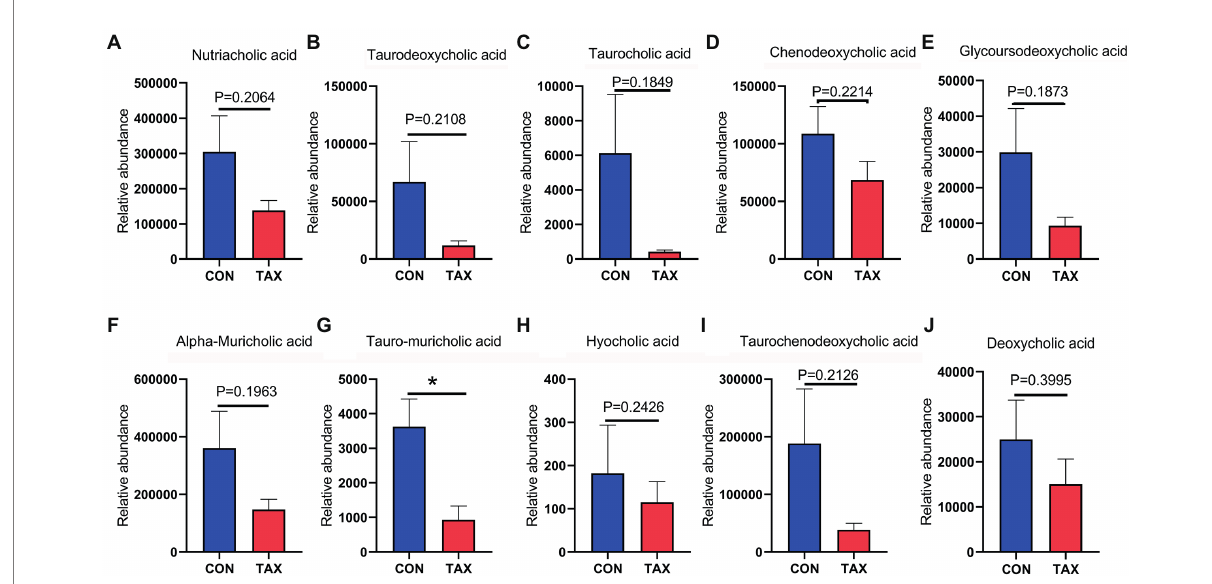
FIGURE 4 TAX decreased blood bile acids. (A) Blood nutriacholic acid level. (B) Blood Taurodeoxycholic acid level. (C) Blood taurocholic acid level. (D) Blood Chenodeoxycholic acid level. (E) Blood Glycoursodeoxycholic acid level. (F) Blood Alpha-Muricholic acid level. (G) Blood Tauro-muricholic acid